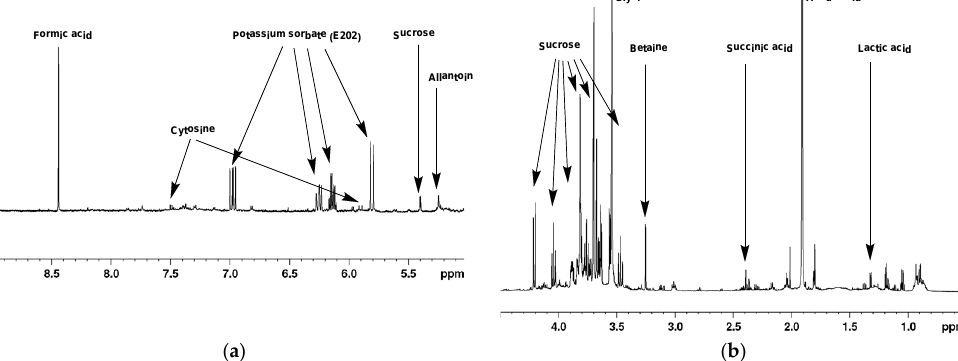
Figure 1. Typical 1 H-NMR spectrum of lyophilized mucus from Helix aspersa (<1 kDa) with assignment of the main metabolites. (1D-noesy experiment with water presaturation, pH = 7.35, 298.0 K). ( a ) 1 H-NMR spectrum in the interval from 5.0 to 9.0 ppm; ( b ) 1 H-NMR spectrum in the interval from 0.5 to 4.5 ppm.